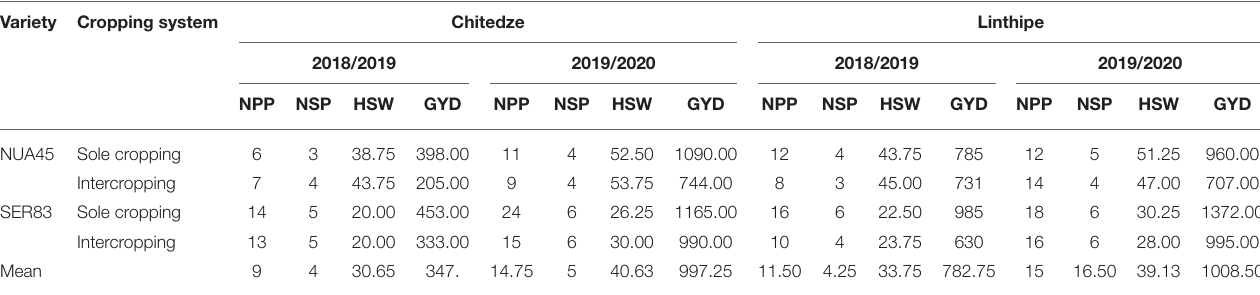
TABLE 5 | Means for agronomic traits of common bean genotypes from a maize–common bean intercropping at Chitedze and Linthipe in 2018/2019 and 2019/2020 growing season. Variety Cropping system